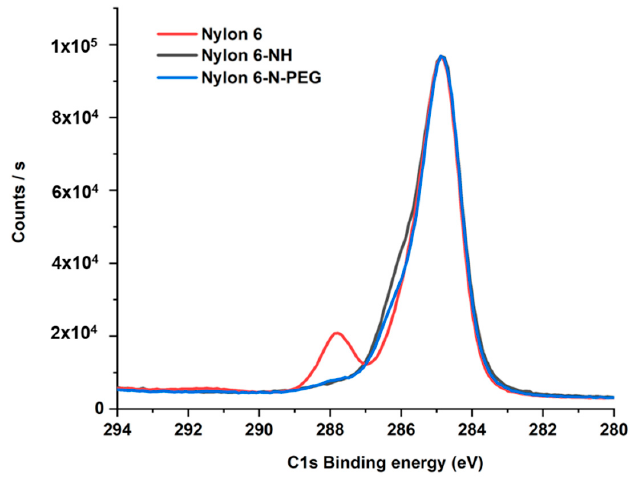
Figure 4. The XPS C 1s spectra of the unmodified and modified Nylon 6 samples. Table 2. XPS data for the unmodified and modified Nylon 6 films. Elemental Composition of Sample Surface (%) Sample